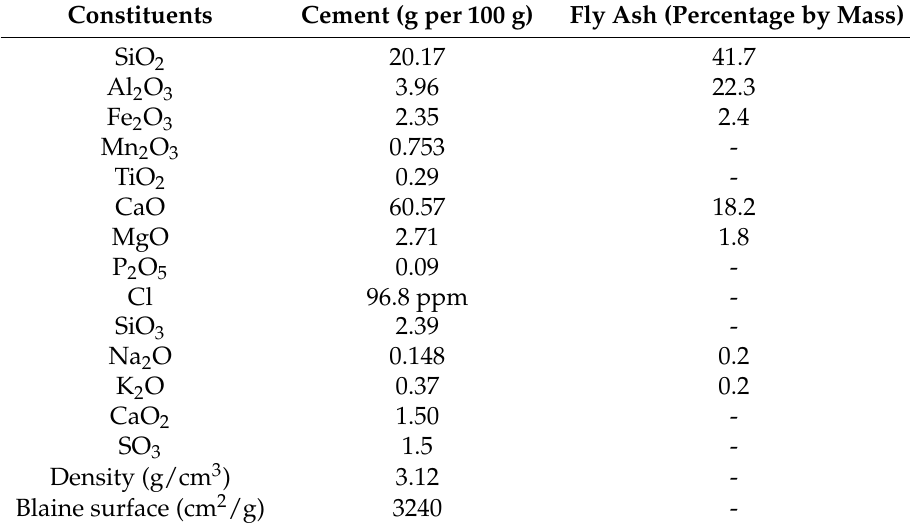
Table 1. Cement and fly ash